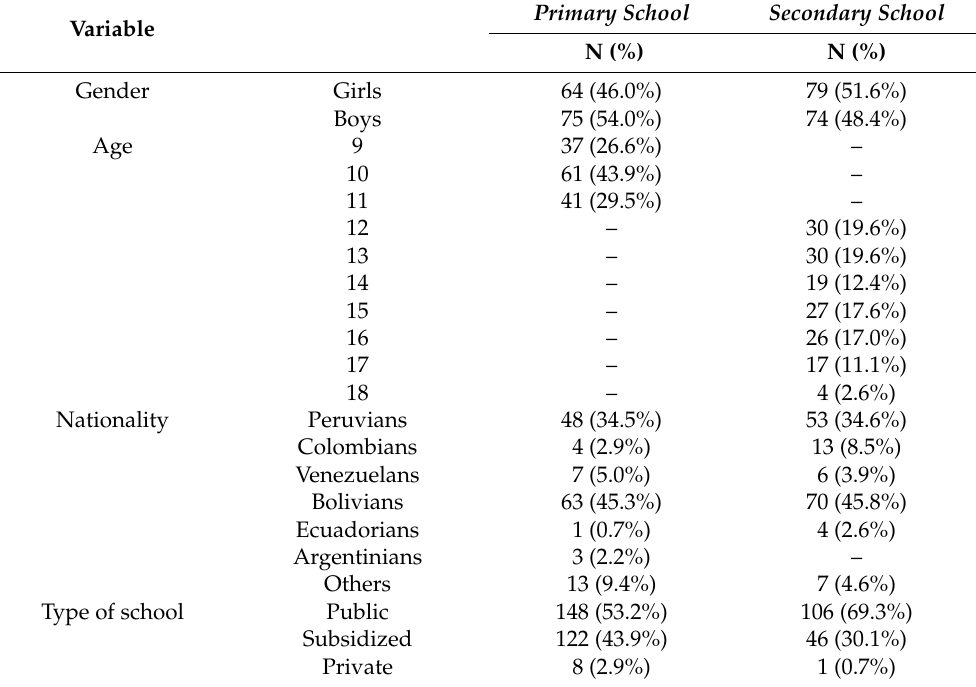
Table 1. Characteristics of the